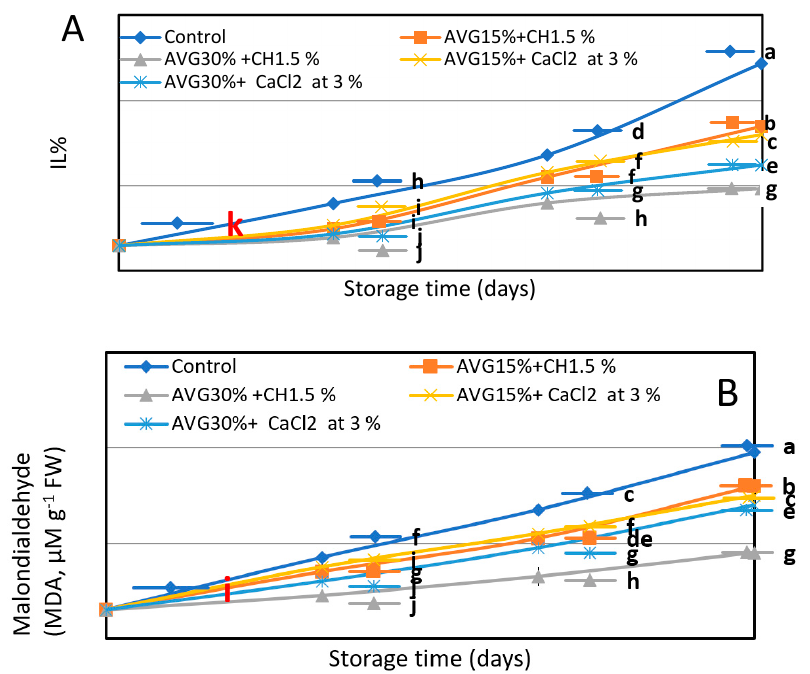
Figure 2. The effect of coating with AVG at 15 and 30% mixed with CH at 1.5% or CaCl 2 at 3% on IL% ( A ), and MDA% ( B ) of ‘sultany’ peaches during cold storing at 3 ± 1 °C and 95 ± 1% RH for 36 days. The standard error (±SE of n = 3) is shown by the vertical bars and the alphabetical letters indicated the significance at p ≤ 0.05 among treatments in each storing period. The average of both trial seasons (2020 and 2021) was analyzed by using Duncan’s Multiple Range Test. p -value of IL%, F1 = 0.506 F2 = 0.566 F1 × F2 = 1.156 and MDA%, F1 = 0.009 F2 = 0.011 F1 × F2 = 0.022. 3.4. H 2 O 2 , O 2 Production, and DPPH Reduction Figure 3 shows the differences in production rates of H 2 O 2 and O 2 • − and antioxidant capacity DPPH% that were influenced by different treatments and the cold storing dura- tion up to 36 days. The obtained results indicate the production rates of H 2 O 2 and O 2 • − increased clearly in all treatments, except for peach fruits coated with a combination of (AVG 30% + CH 1.5%) that slightly improved the production rates of H 2 O 2 and O 2 • − be- ginning from the 12th day until the end of the storing period, while registered the lower production rate of H 2 O 2 (0.26 mmol min − 1 g − 1 FW) and O 2 • − (0.53 mmol min − 1 g − 1 FW) until the end of the experiment compared with the other treatments and control. The antioxi- dant effects of peach fruit influenced by all treatments and storing time (36 days) was recorded as the available radical scavenging activity effect via the DPPH% reduction pro- cess. When considering the antioxidant effects, the treated fruits showed different and intense levels of antioxidant synopsis compared to (control), which indicated the lower effect with 33.37% in the 36th day. The higher DPPH% activity was demonstrated by a combination of (AVG 30% + CH 1.5%) treatment, which had a percent inhibition of 39.71% at 36th day. Therefore, (AVG 30% + CH 1.5%) edible coating combination had considera- bly generated the DPPH radical scavenging effect in peach fruit.